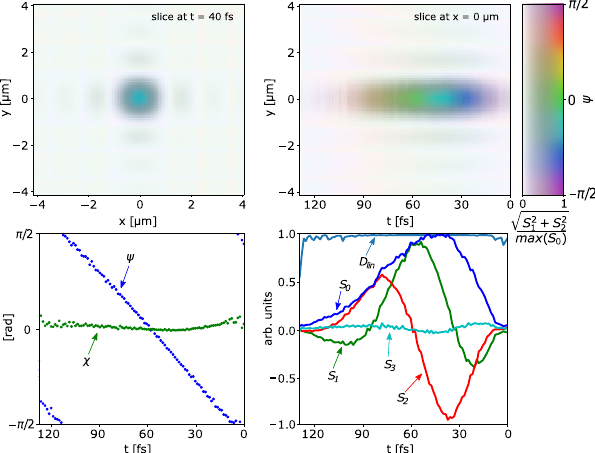
FIG. 9. Radiation polarization properties for the setup geometry optimized for temporal polarization shaping. Stokes parameters averaged over 1.3 fs (19 simulation slices). Here we assume 10 mm aperture size. Top plots depict radiation intensity and orientation of the polarization plane in false colors as a function of transverse coordinates and time. Bottom left plot depicts angles of Stokes vector averaged over transverse coordinates as a function of time. Bottom right plot depicts the corresponding Stokes vector